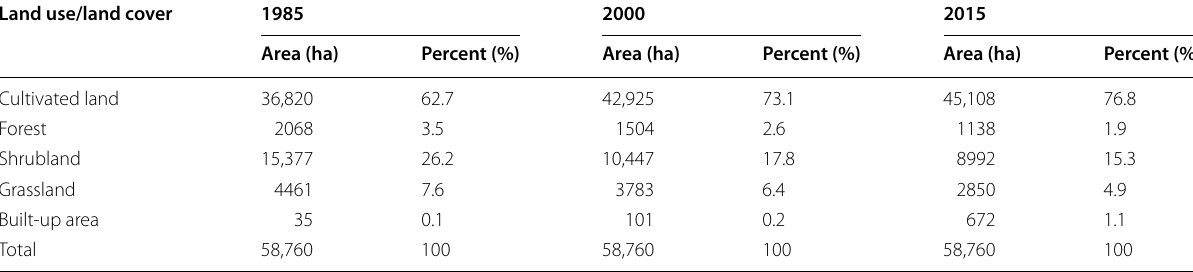
Table 5 Area of LU/LC class from 1985 to 2015 periods in the Andassa watershed Land use/land cover